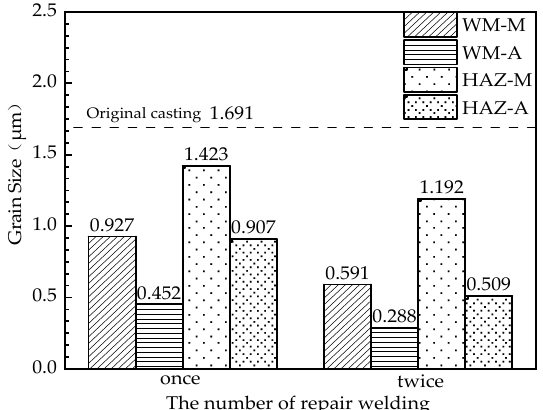
Figure 7. Average grain size distribution of martensite and reversed austenite in different areas with repair welding once and twice.